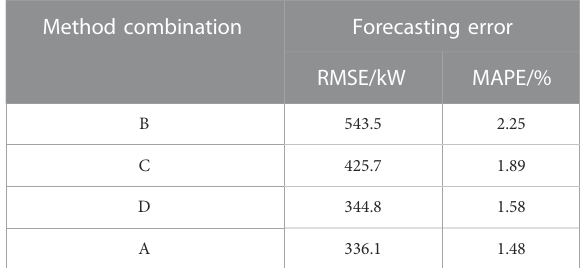
TABLE 4 Forecasting errors of different method combinations.